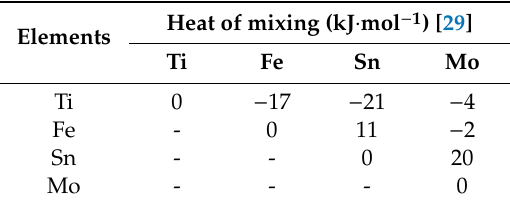
Table 2. Heat of mixing of Ti–Fe–Sn–Mo